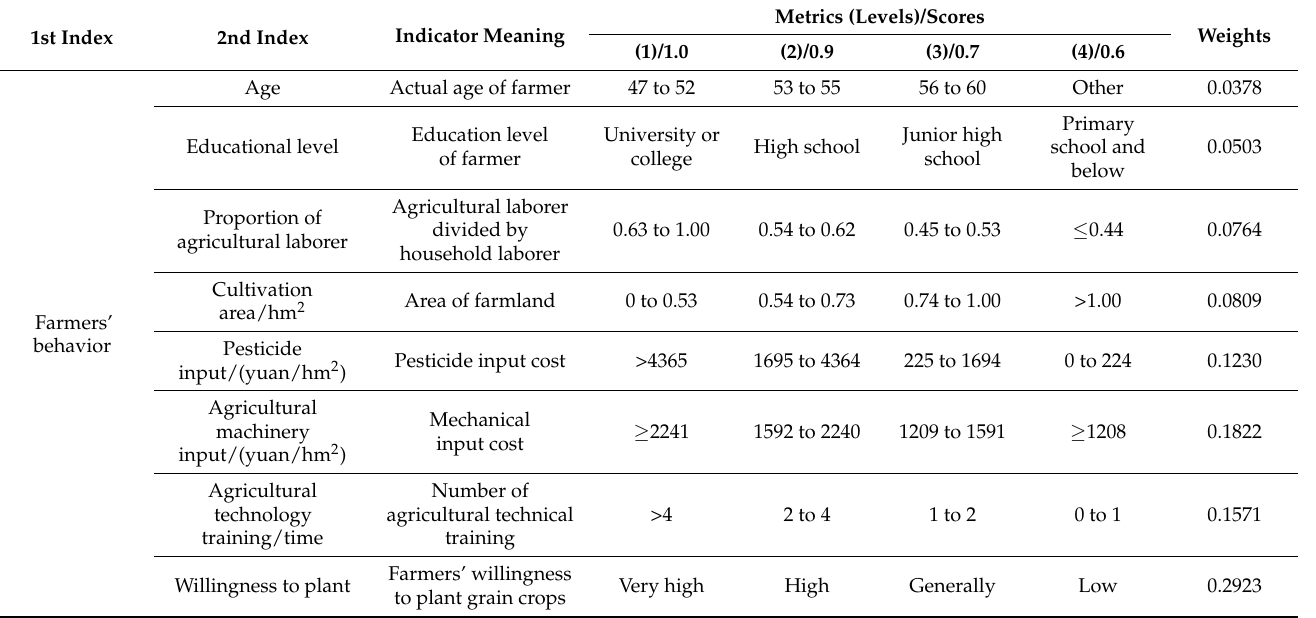
Table 1. Classification and weight of farmers’ behavior